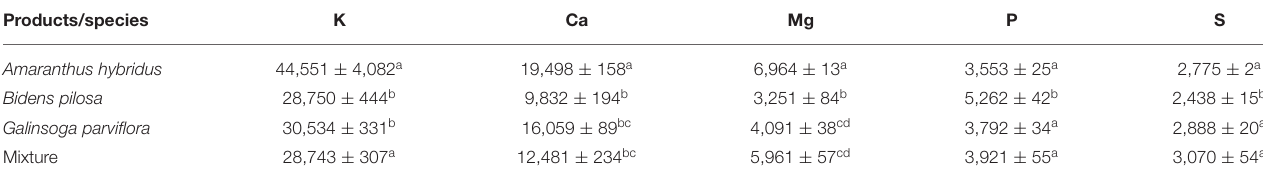
TABLE 2 | Macronutrients’ contents of lombi (mg.kg − 1 dry matter). Products/species